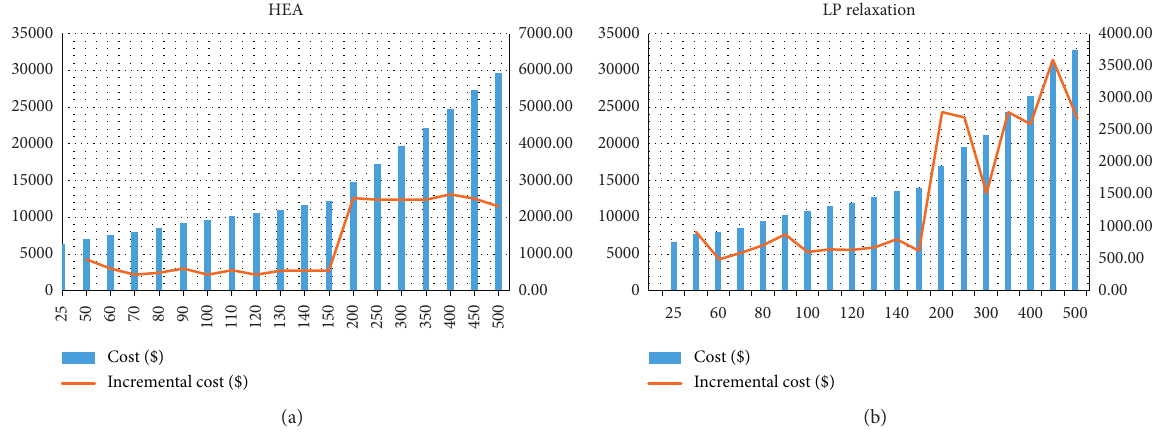
Figure 5: Sensitivity analysis of LP and HEA to objective